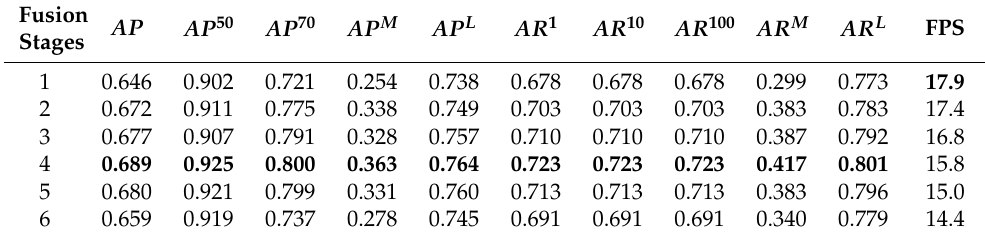
Table 2. Analysis on the multi-scale IASM.